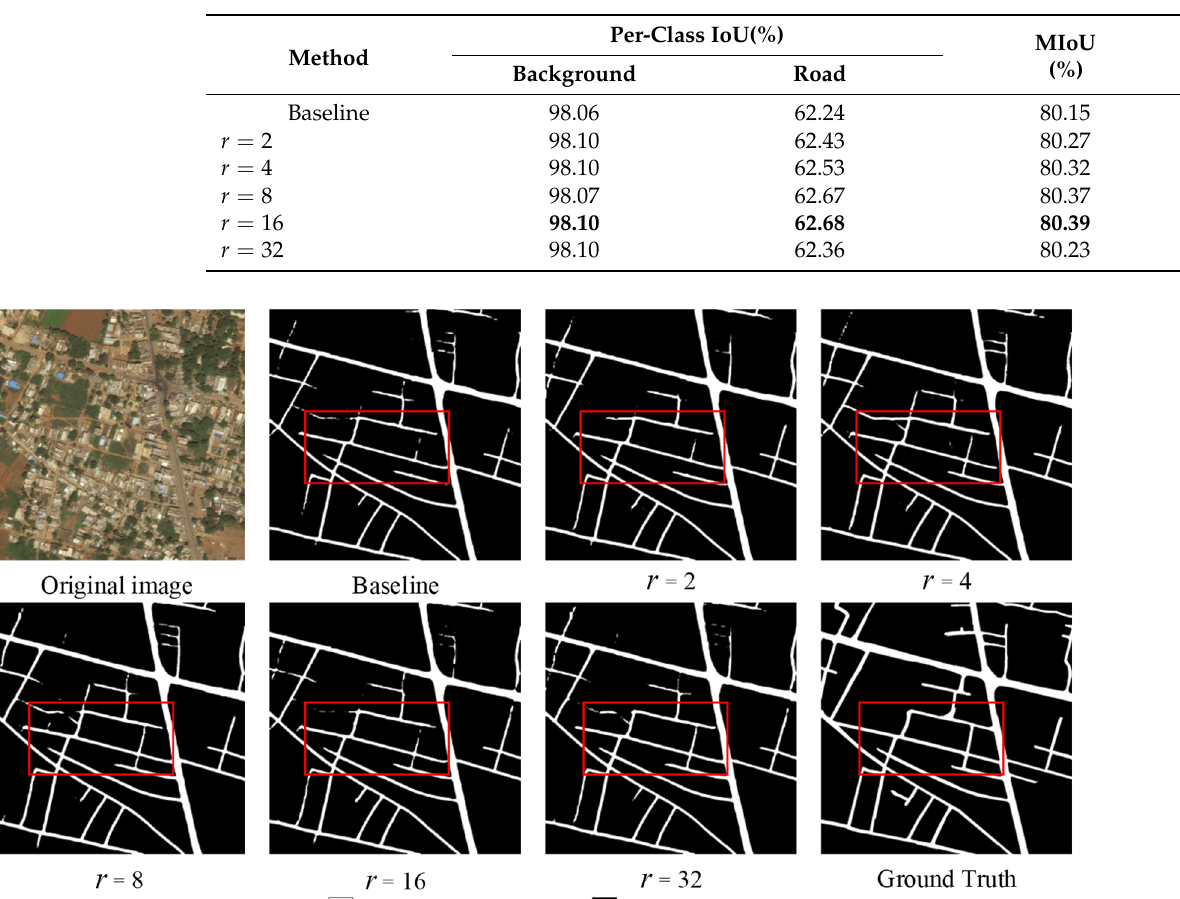
Table 2. Comparison of dimensionality reduction rates of strip attention modules based on the DeepGlobe dataset. (Data in bold are the best results.).